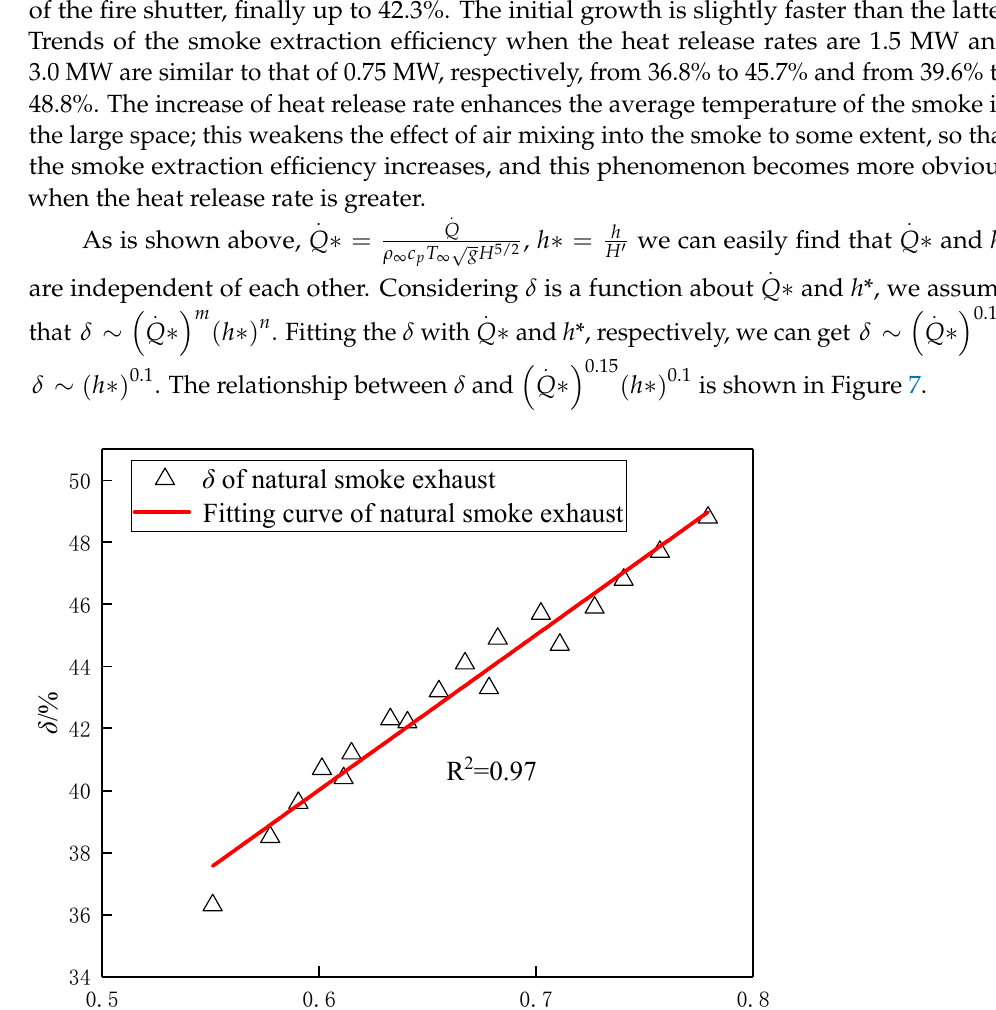
10 of 17 Figure 6. Relationship between the dimensionless descending height of the fire shutter and the smoke extraction efficiency. In Figure 6, the smoke extraction efficiency increases steadily with the increase of fire shutter descending height in all conditions. In addition, the greater heat release rate pos- sesses bigger smoke extraction efficiency, ranging from 39.6% to 48.8% at the biggest heat